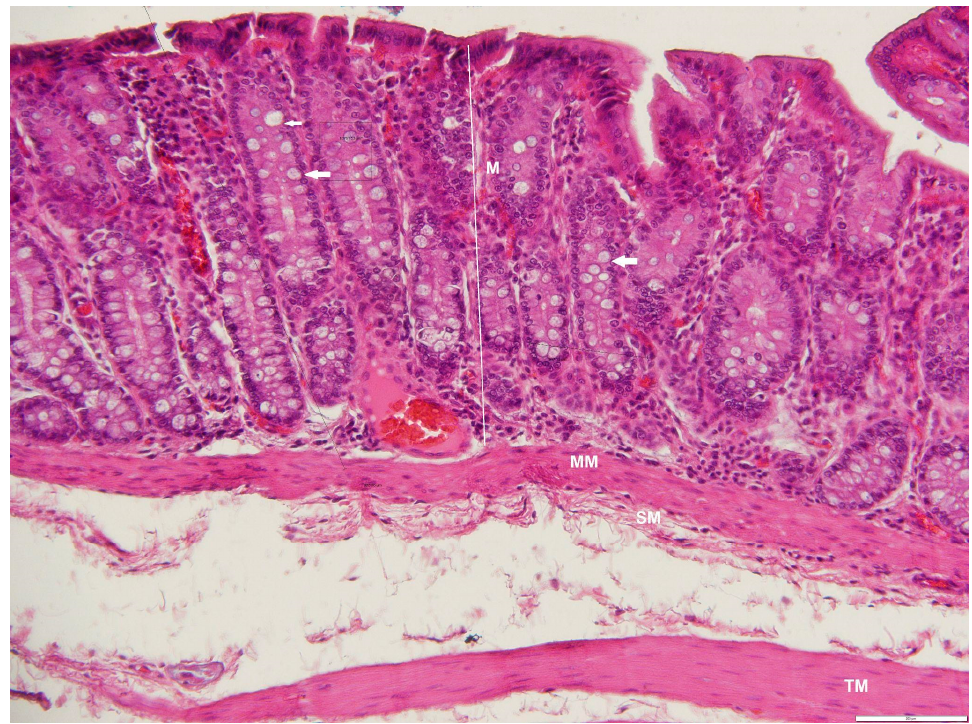
Figure 14. Photomicrograph of a cross-section through the rectum of an adult male D. leporina , showing goblet cells (arrows) H&Ex200. M—mucosa; MM—muscularis mucosa; SM—submucosa; TM—tunica muscularis.